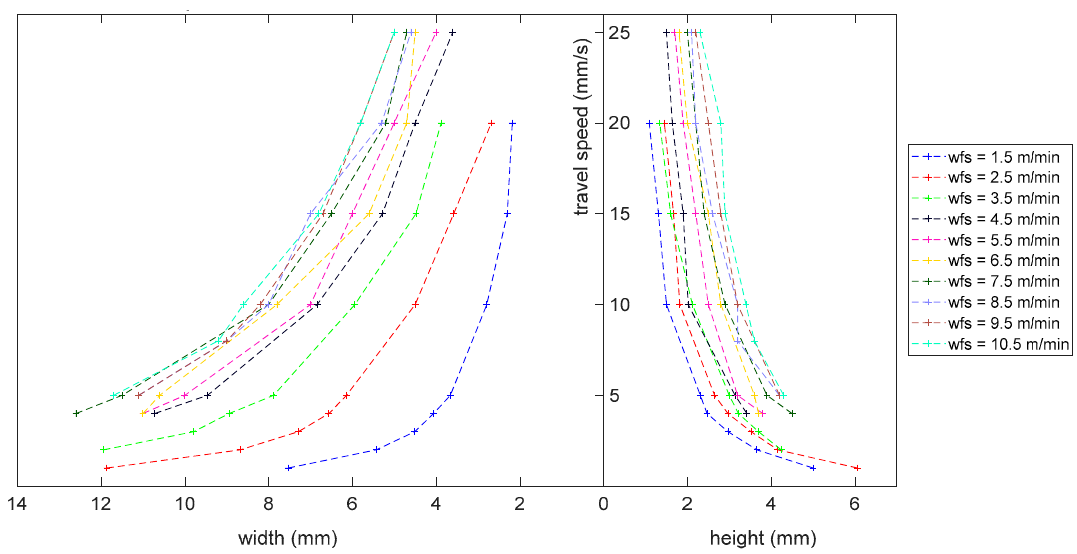
Figure 4. Width and height of weld bead profile dependent on travel speed and wire feed speed.